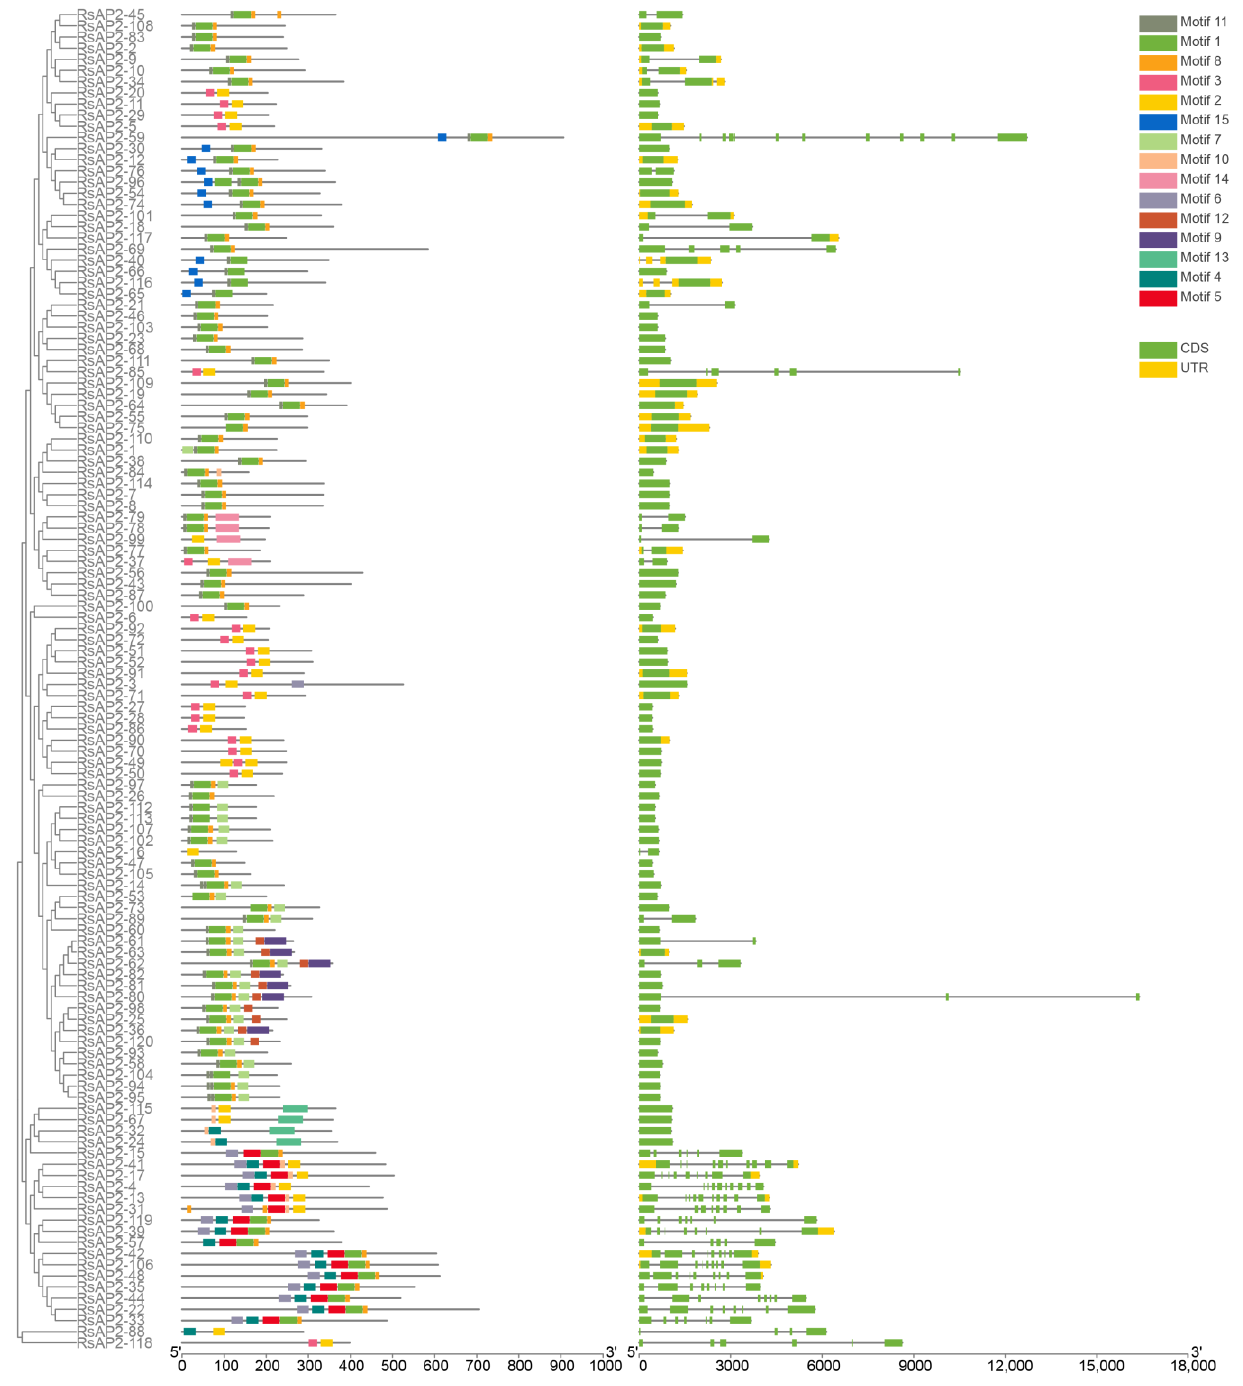
Figure 3. Chromosomal distribution and gene duplication analysis of RsAP2 genes